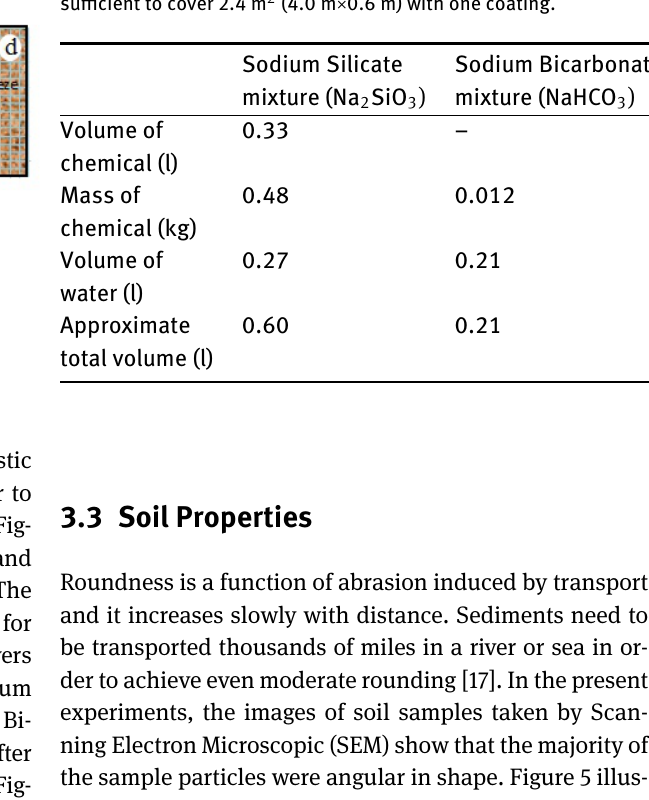
Table 2: Relative quantities of chemicals used for bed